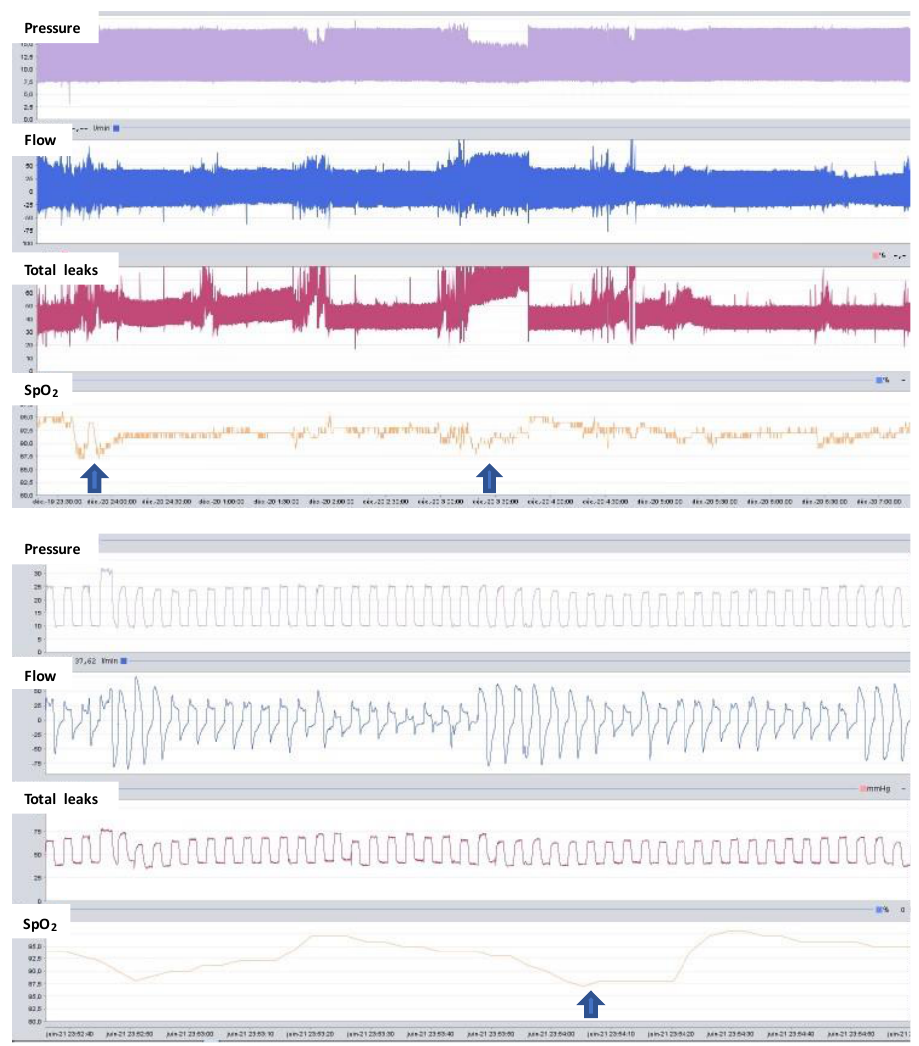
Figure 5. Nocturnal pulse oximetry using a sensor connected to the ventilator. Upper panel shows the full night recording of pressure, flow, total leaks, and SpO 2 . Two prolonged desaturations marked with the arrow occur due to large increase in leakages. Lower panel show a focus over a 2 min period. A short desaturation marked with the arrow occurs, following a decrease in flow without an increase in leaks, suggesting an upper airway obstruction.